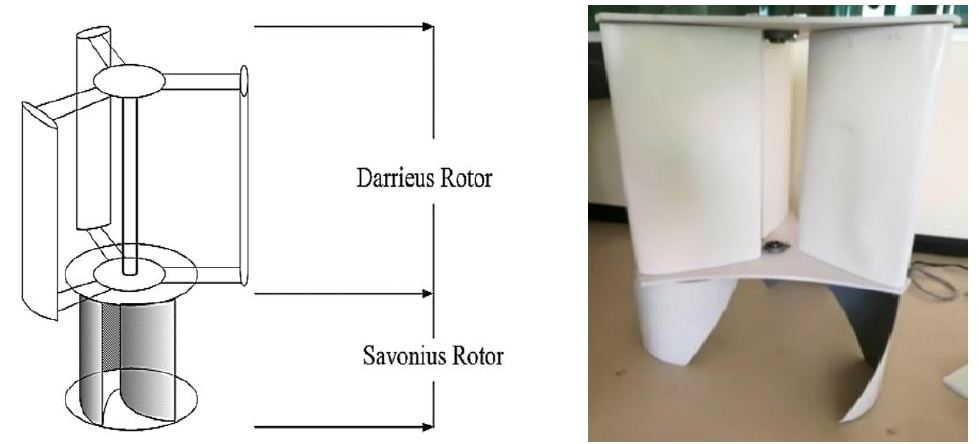
Figure 9. The double-rotor (Savonius and Darrieus) for wind turbine.